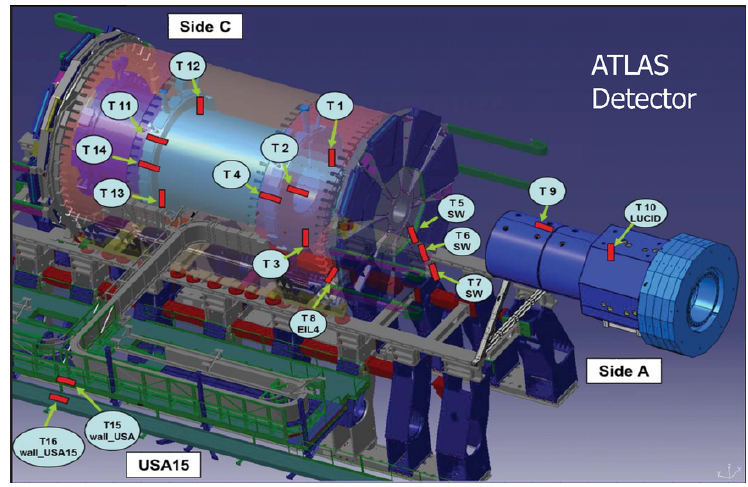
Figure 32. Overview of TPX detector positions in the ATLAS detector (partial illustration) and in the ATLAS cavern. The devices TPX01 to TPX16 are indicated as T1 to T16. Taken from Ref. [14]. Table 12. TPX device locations with respect to the interaction point. Z is the longitudinal distance from the interaction point, and R is the distance from the beam axis. Their uncertainty is about 10mm. The particle fluxes, normalized to 100% acquisition time, are listed. Taken from Ref. [14].